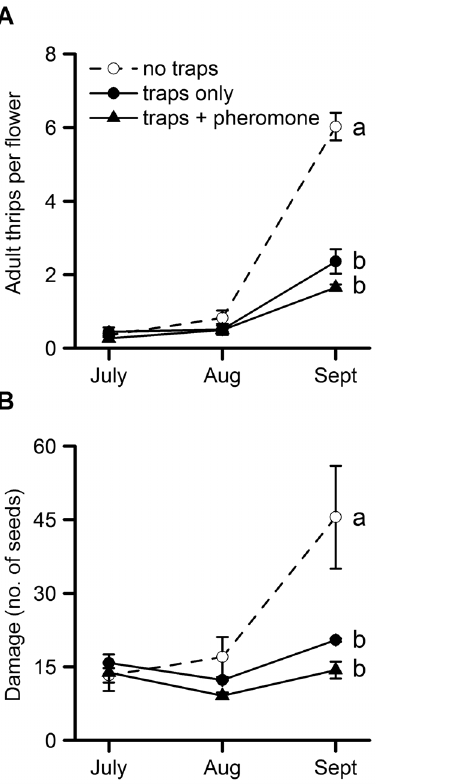
Figure 2. The effect of mass trapping on thrips numbers and fruit damage. Samples taken on 9 July, 8 August and 10 September 2012 in: plots without blue sticky roller traps; plots with blue sticky roller traps only; and plots with blue sticky roller traps and pheromone lures. (A) mean adult thrips per flower 6 SE and (B) mean fruit damage 6 SE. Damage was recorded as the number of seeds surrounded by bronzing on swollen white fruit. Differences were significant in September (thrips numbers P , 0.001, fruit damage P =0.006) ( n =3). Means with the same letter are not significantly different ( P . 0.05).